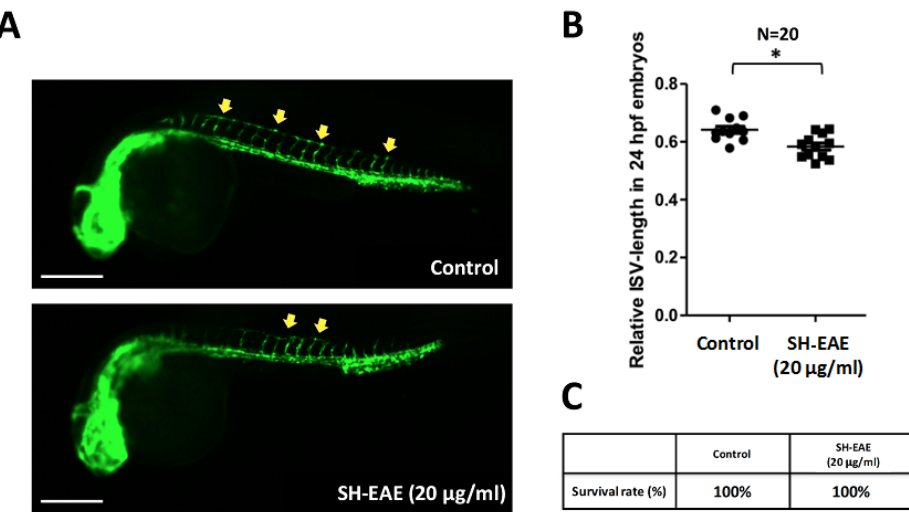
Figure 9. SH ‐ EAE decreased angiogenesis in the zebrafish model. ( A ) The image is representative of 20 individual zebrafish larvae Tg(flk1:EGFP) under a fluorescence light microscope after exposure to SH ‐ EAE (20 μ g/mL) or vehicle control for 14 h. The upper image is untreated larvae as the control group, and the lower image is larva treated with SH ‐ EAE (20 μ g/mL). The yellow arrows depict the regions where fluorescent intersegmental vessels (ISVs) were obvious. Scale bars = 200 μ m. ( B ) The formation of the ISVs in zebrafish larvae at 24 hpf. n = 20 embryos pooled from two independent experiments. Centerlines indicate median values. The p ‐ value from the Mann–Whitney U test is less than 0.05 (* p < 0.05). ( C ) The effect of SH ‐ EAE on the survival rate of zebrafish embryos. Data are expressed as percentages. n = 20 for each group.